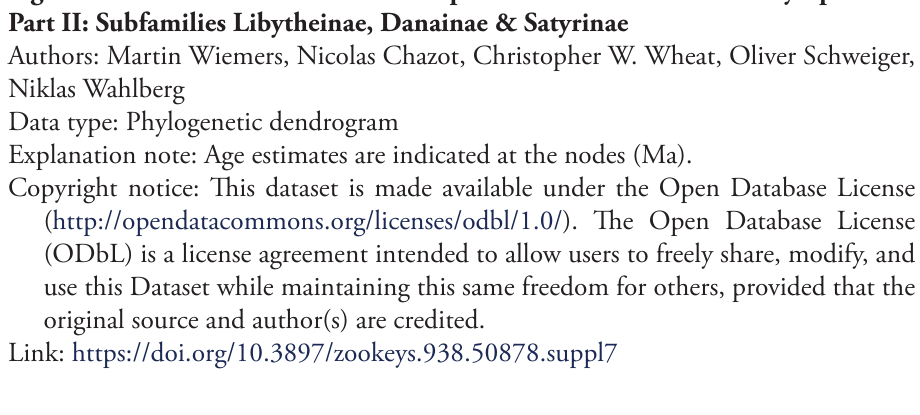
Figure S5. Time-calibrated tree of European butterflies Section IV: Nymphalidae Part II: Subfamilies Libytheinae, Dan ainae & Satyrinae